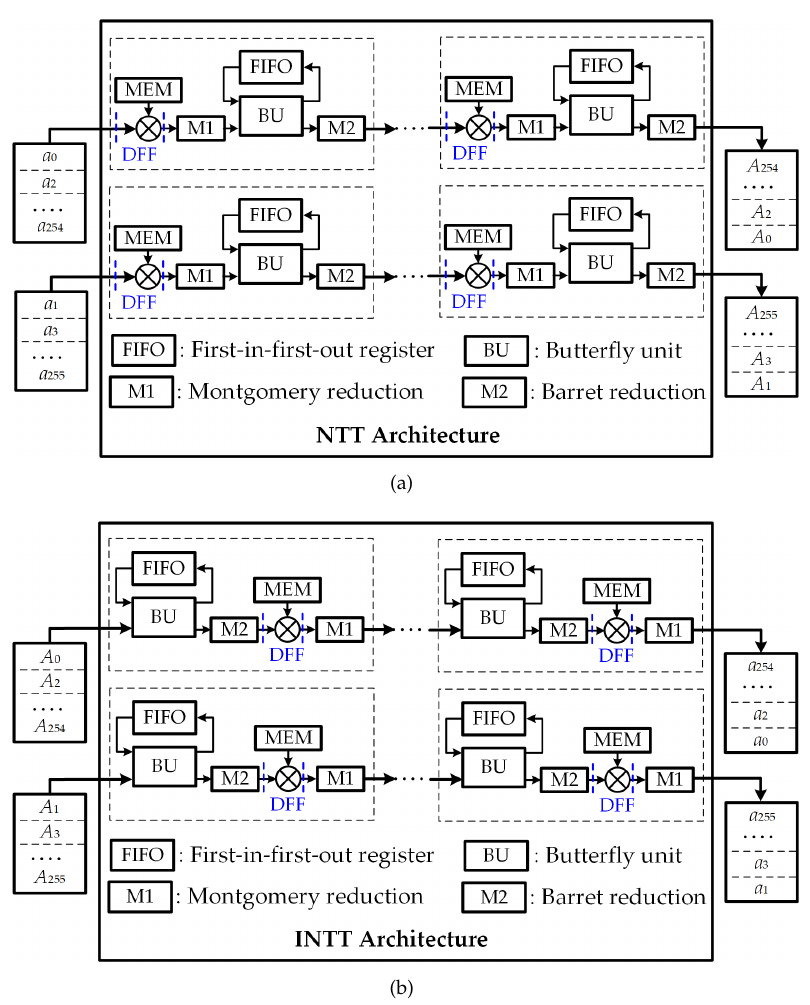
Figure 1. Proposed DDF-based architecture for Kyber ( a ) NTT architecture and ( b ) INTT architecture.